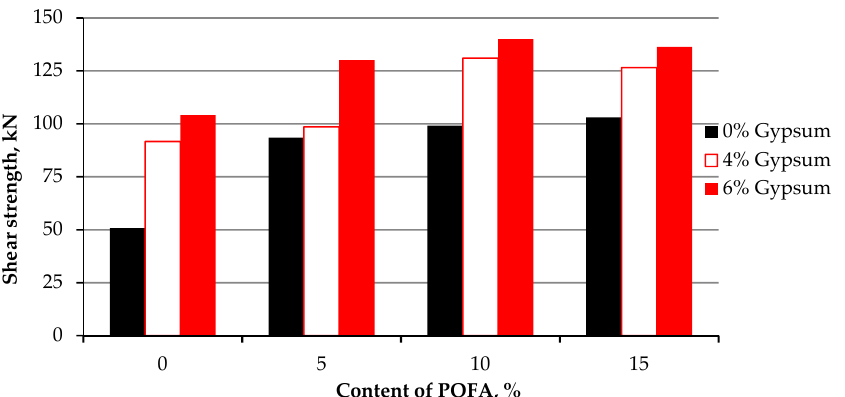
Figure 12. Stress–strain curve of kaolin and stabilized kaolin with gypsum and POFA tested after 28 days of curing. Table 6. Summary of variance and standard deviation of the specimen of shear strength after 28 curing days.